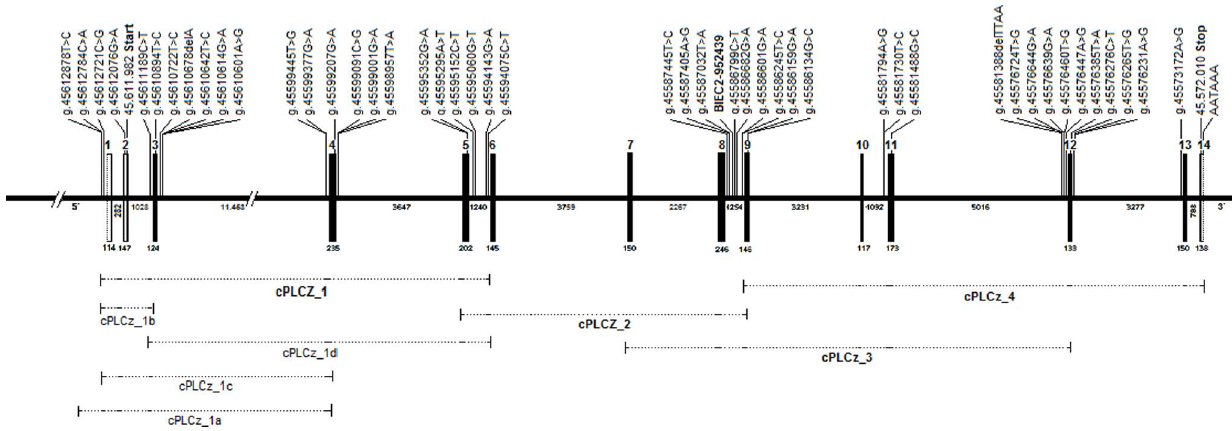
Figure 4. Equine gene model of PLCz1 and polymorphisms detected. Sequence analyses of PLCz 1 revealed four transcripts of which the full- length variant (JX545317) is shown. Translated exons are shown as solid black boxes, untranslated exons as open boxes. Numbers above indicate the exon number. Continuous lines represent introns, numbers below the exons and introns indicate the sizes in base pairs. The predicted translation start and stop and the polyadenylation site is indicated. The highly associated single nucleotide polymorphism (SNP) BIEC2-952439 identified in a genome-wide association study (GWAS) is given in bold. The dashed lines below represent the coverage of the complementary DNA (cDNA) primers. doi:10.1371/journal.pone.0109675.g004 PLOS ONE |